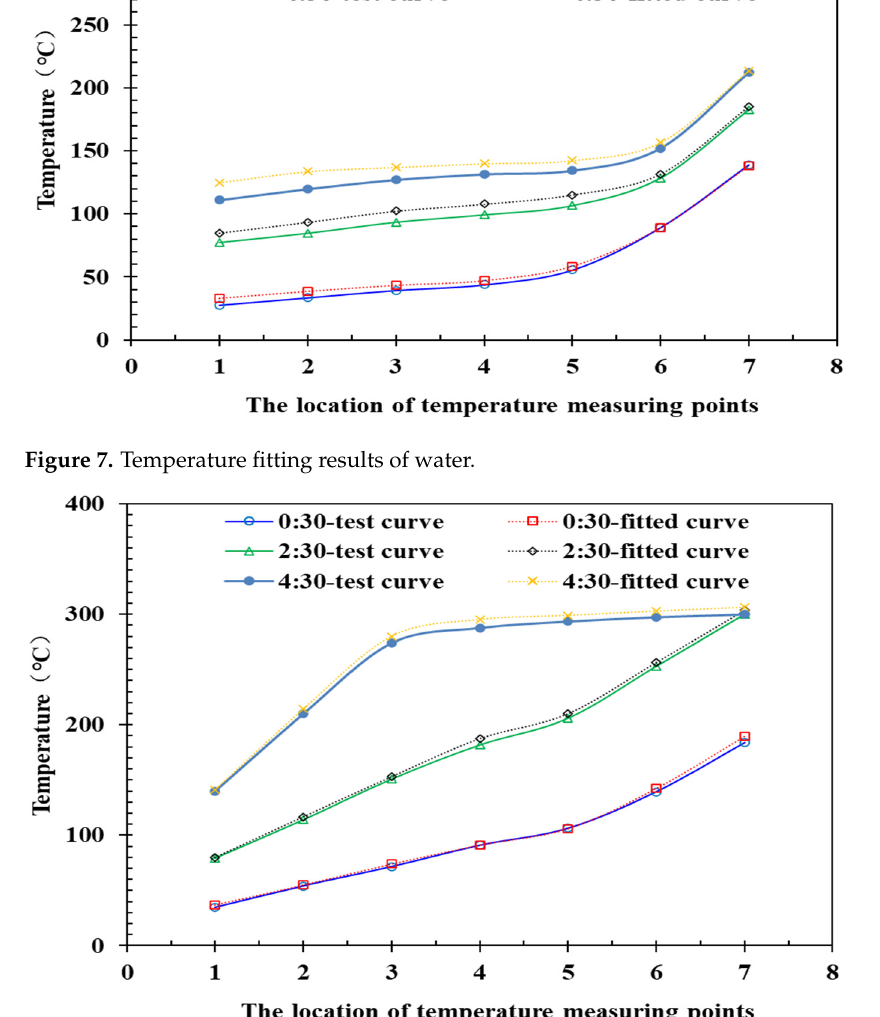
Figure 8. Temperature fitting results of heat-conduction oil. Table 2. The key parameters of the laboratory-size radial